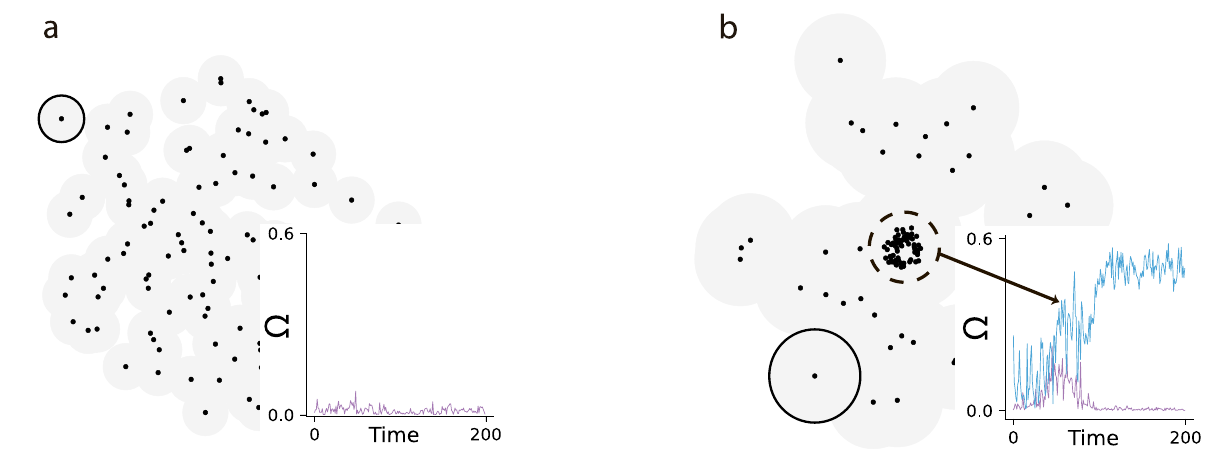
Figure 7. Typical swarm configurations for different size of the perception zone as compared to the size of the group. Configurations are shown for 100 agents. Lite-gray shadows designate the perception zones of the animals (encircled for a single agent), while small black circles show the individual comfort zones. ( a ) When the size of the perception zone is significantly smaller than the group size a chaotic motion with zero angular velocity is observed. Inset: Time dependence of the average angular velocity �( t ) of the swarm. ( b ) As the size of the perception zone increases, swirling emerges in a subgroup. In this case swirling coexists with the chaotic motion of the rest of the group. Inset: Time dependence of the average angular velocity �( t ) of the whole group (purple) and of the swirling subgroup